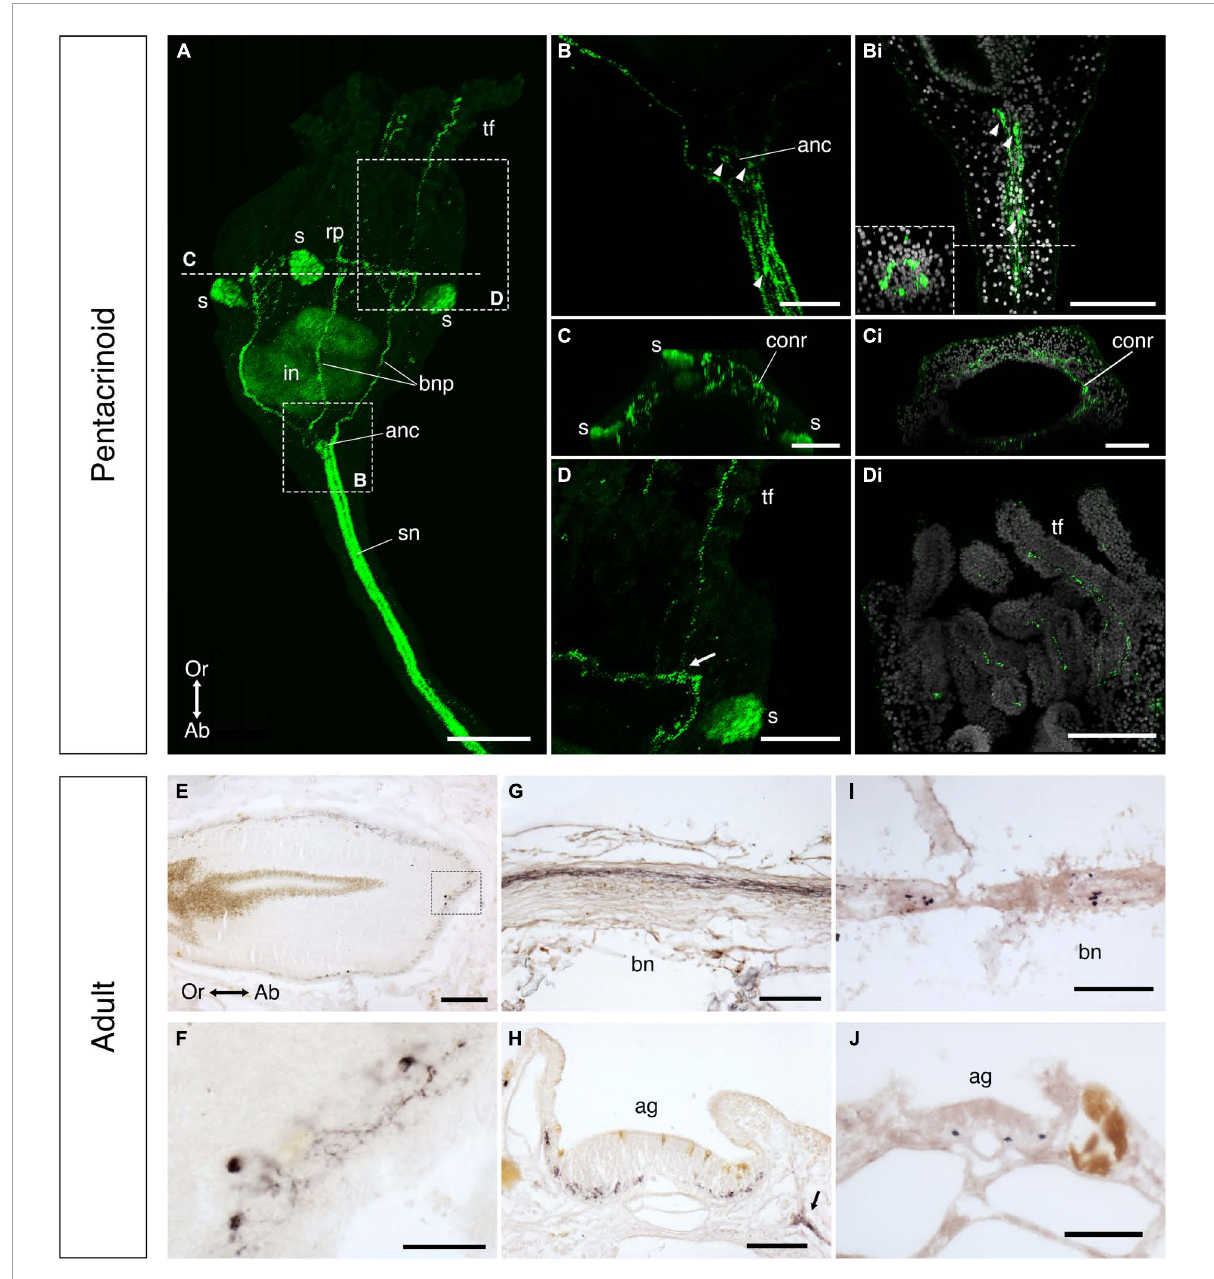
FIGURE12 Localization of calcitonin-type neuropeptide expression in post-metamorphic stages of Antedon mediterranea . (A–Di) Immunofluorescent labeling of calcitonin-type neuropeptide expression in the pentacrinoid stage using an antiserum to the A. rubens calcitonin-type neuropeptide ArCT. Immunolabeling is observed in the calyx, stalk, and tube feet (A) . High magnification images show five tracts containing strongly labeled fibers in the stalk nerve (B,Bi) , and fibers and cell bodies (arrowheads) in the aboral nerve center (B,Bi) , from which five immunolabeled brachial nerve primordia project orally (A,B) to the circumoral nerve ring [ (A) , resliced for oral view in panel (C,Ci) ]. Labeled fibers in the tube feet (D,Di) appear to originate in the circumoral nerve ring [white arrow in panel (D) ]. (E,F) Localization of calcitonin-type neuropeptide expression in sections of the adult calyx (E,F) and arm (G,H) as revealed by immunohistochemistry using an antiserum to the A. rubens neuropeptide ArCT (E–H) and by mRNA in situ hybridization using probes for A. mediterranea calcitonin-type precursor (AmCT) transcripts (I,J) . In the calyx, immunostaining is located at the base of the mucosa of the esophagus (E) , where high magnification images show staining located in cell bodies and fibers (F) . In a sagittal section of an arm (oral side uppermost), immunostained fibers can be seen running longitudinally in the brachial nerve (G) . In a transverse section of an arm (oral side uppermost), immunostained cells/fibers can be seen in the ectoneural region of the nervous system at the base of the ambulacral groove (H) and in fibers located aboro-laterally to the ambulacral groove (black arrow in panel H ), which may be derived from hyponeural neurons. Consistent with immunohistochemical analysis of calcitonin-type neuropeptide expression, mRNA in situ hybridization reveals AmCT precursor transcripts in cells located in the brachial nerve (I) (oral side uppermost) and at the base of the ectoneural region of the ambulacral groove (J) (oral side uppermost). Scale bar is 100 µ m for (A,E,G,I) ; 75 µ m for (B–Di,H,J) ; 25 µ m for (F) . Ab, aboral side; ag, ambulacral groove; anc, aboral nerve center; bn, brachial nerve; conr, circumoral nerve ring; in, intestine;